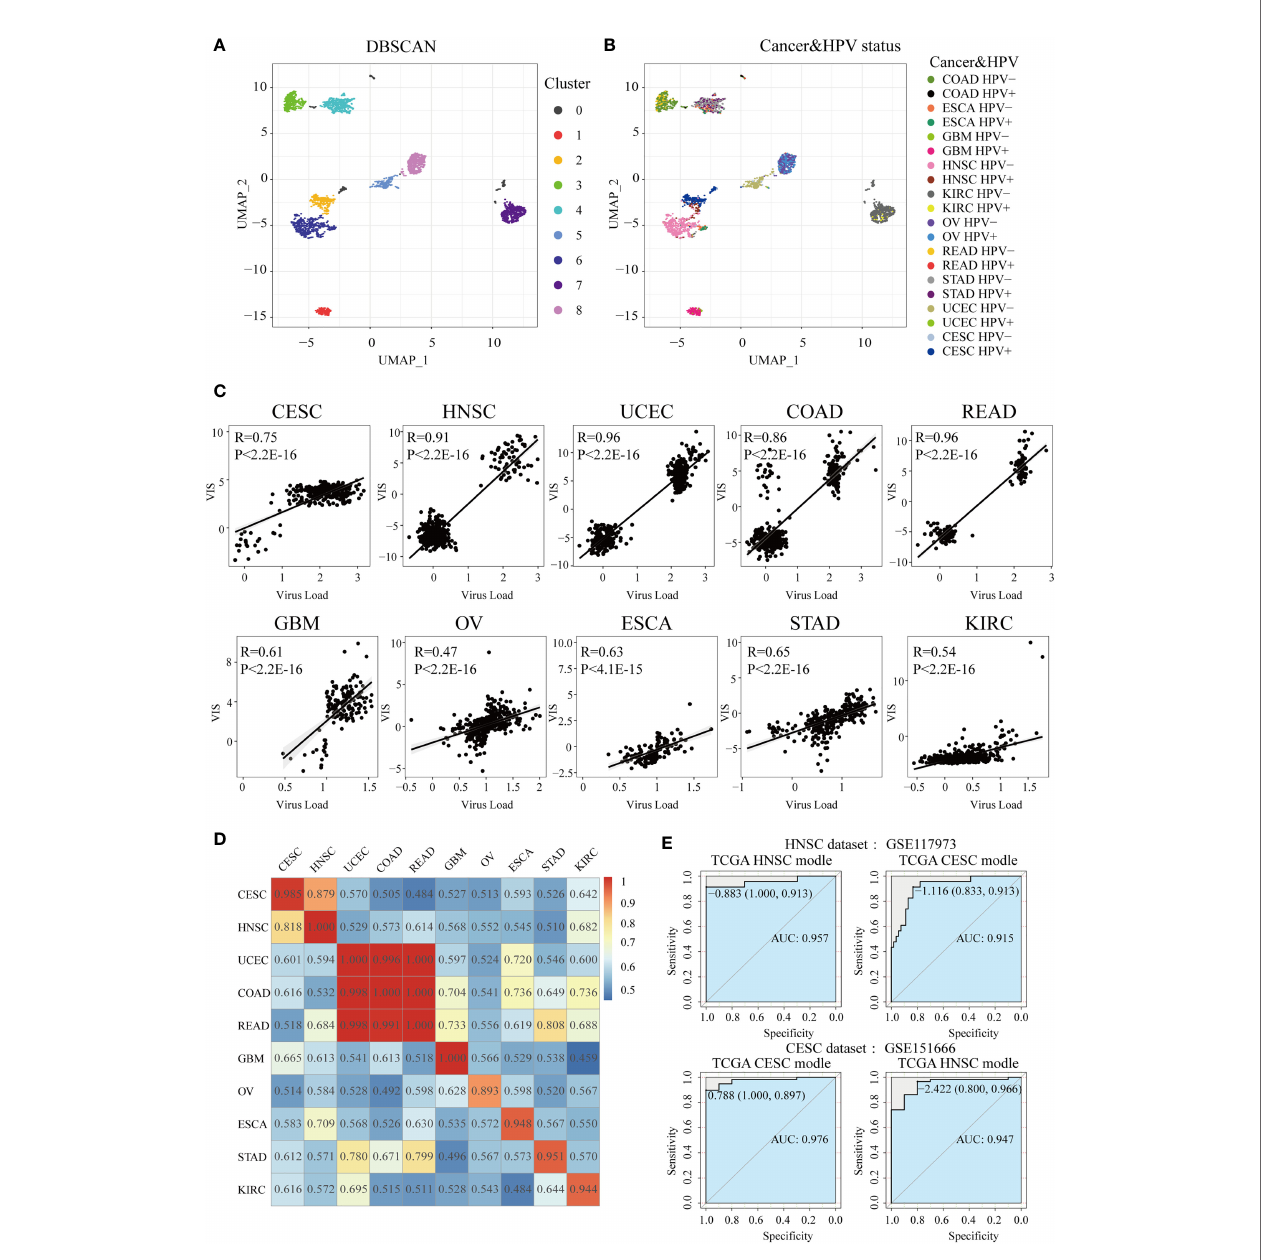
FIGURE 5 | Construction of HPV the prediction model. After UMAP (Uniform Manifold Approximation and Projection) dimensionality reduction, all samples are projected to a two-dimensional coordinate system. The colors of the points in (A) and (B) represent the different clusters after DBSCAN (Density-Based Spatial Clustering of Applications with Noise) clustering and HPV status in different cancer types, respectively. (C) The Spearman correlation between VIS and NRPM in each cancer type. (D) A heatmap shows the AUC values of prediction models which were trained in one cancer type (rows) and applied to the others (columns). (E) Two GEO data sets were used for external veri fi cation of HPV status prediction models derived from TGCA HNSC and CESC